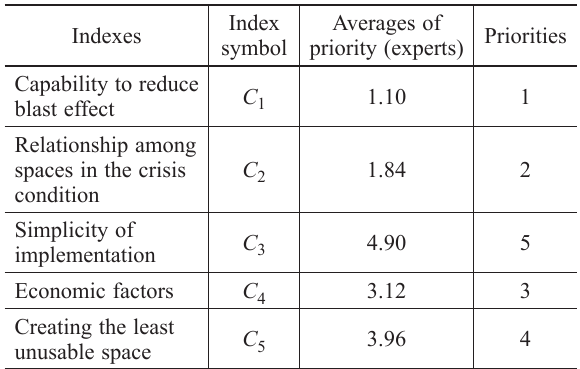
Table 3. Architectural priorities reflected by indexes